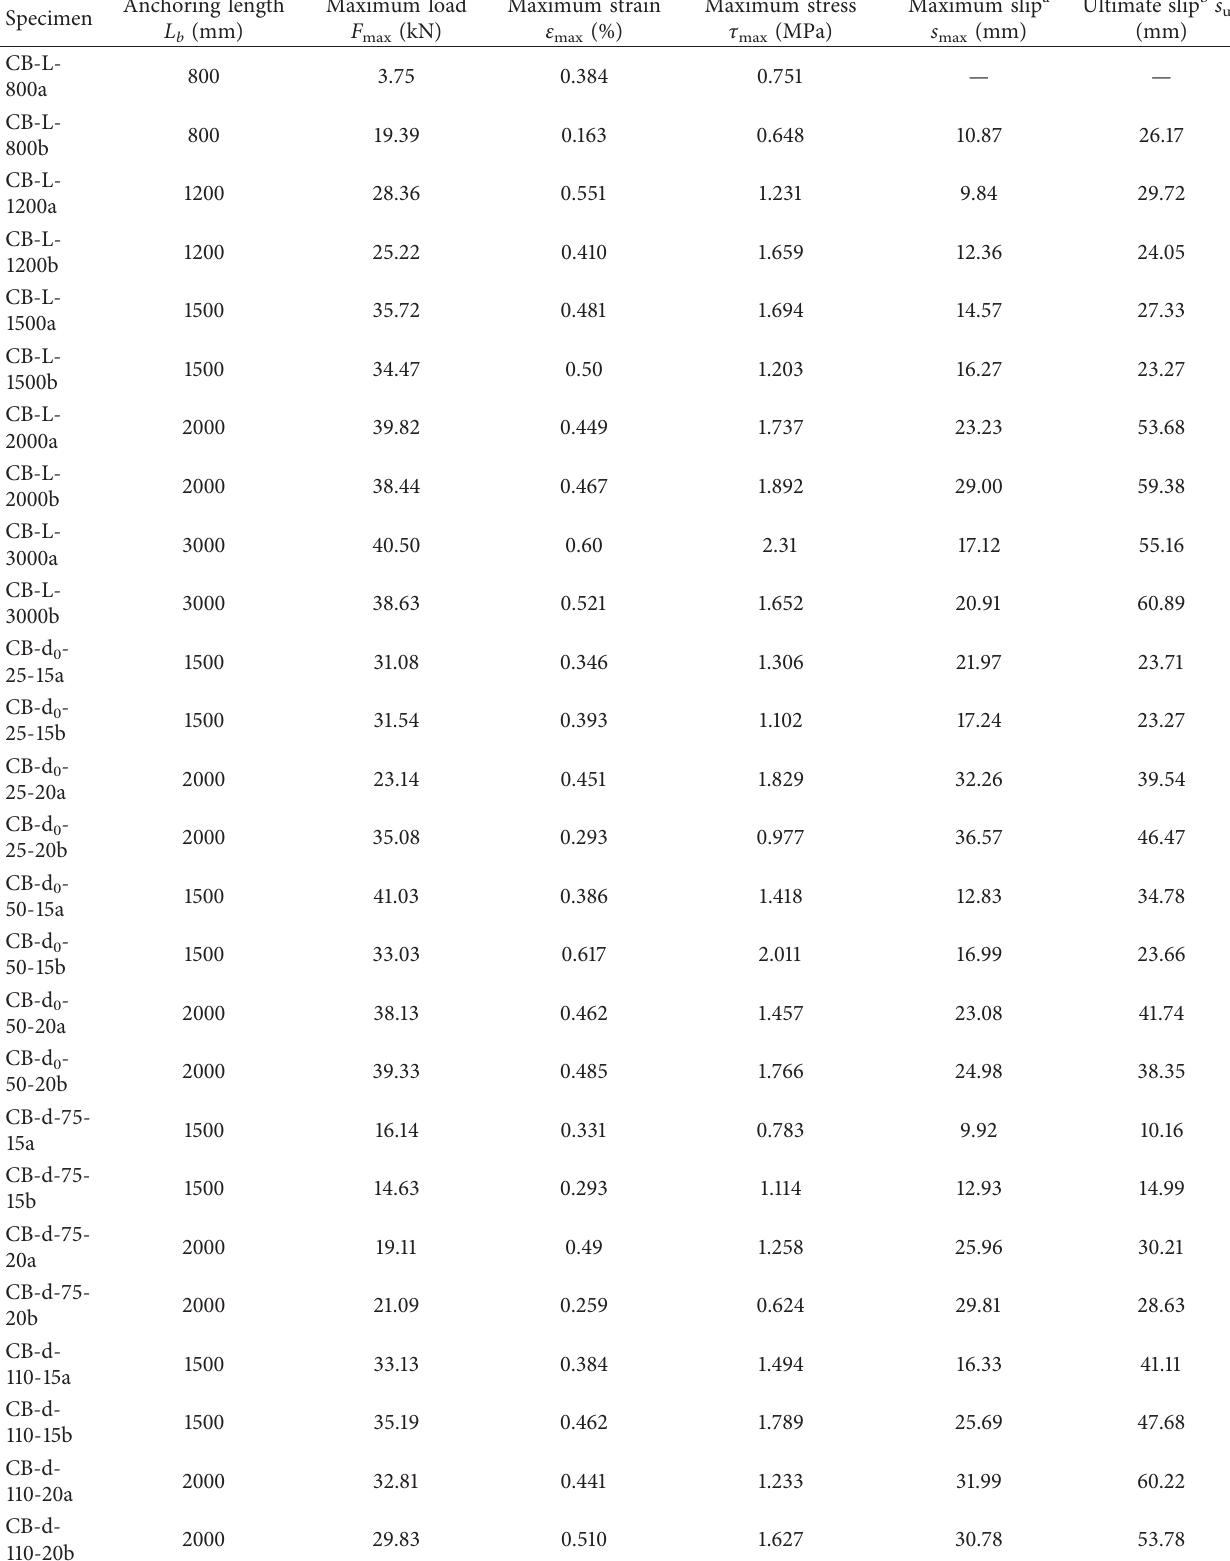
Table 8: The results of the pull-out experiment of the interface between bamboo bolt and modified slurry.